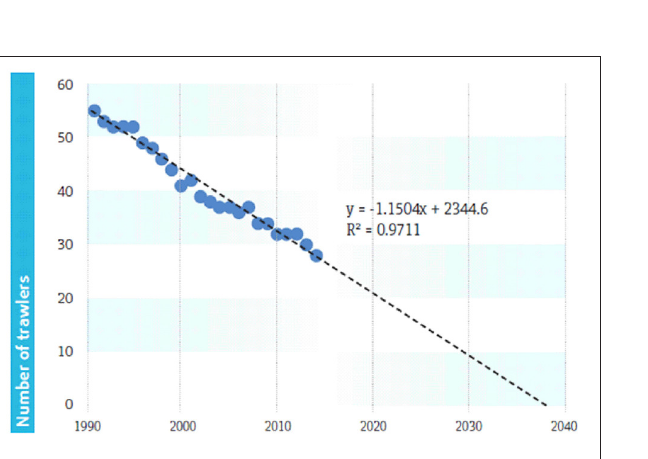
FIGURE 6 | Number of bottom trawlers in Mallorca during the last 25 years with the corresponding linear regression fit and its extrapolation until the fleet disappearance